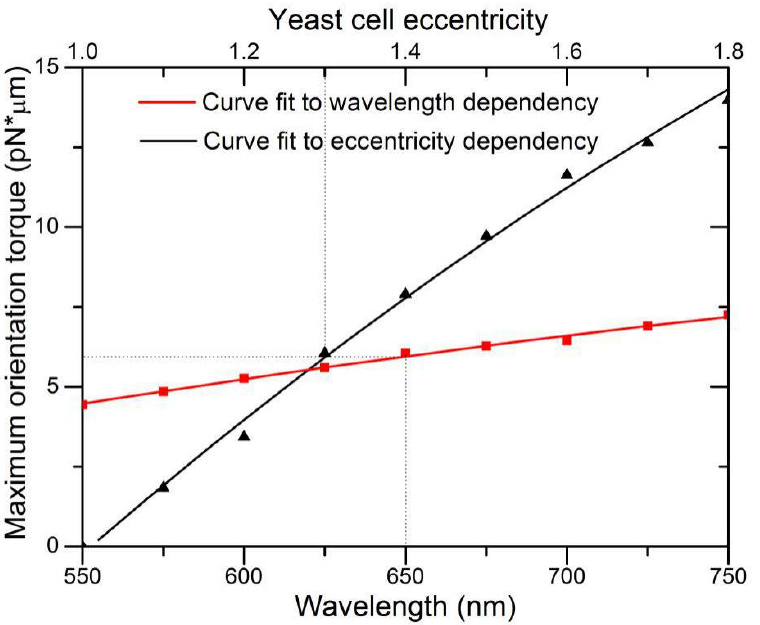
Figure 8. Dependence of maximum holding torque on wavelength and cell eccentricity. Dotted line denotes the case of eccentricity of 1.3 and illumination at 650 nm.